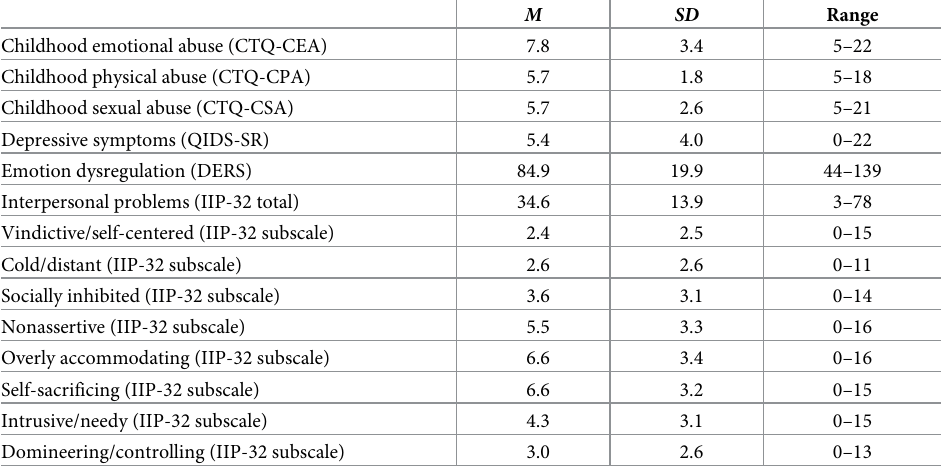
Table 3. Descriptive statistics of the self-report measures of severity of childhood abuse, depressive symptoms, emotion dysregulation, and interpersonal problems in female college students ( N = 276).